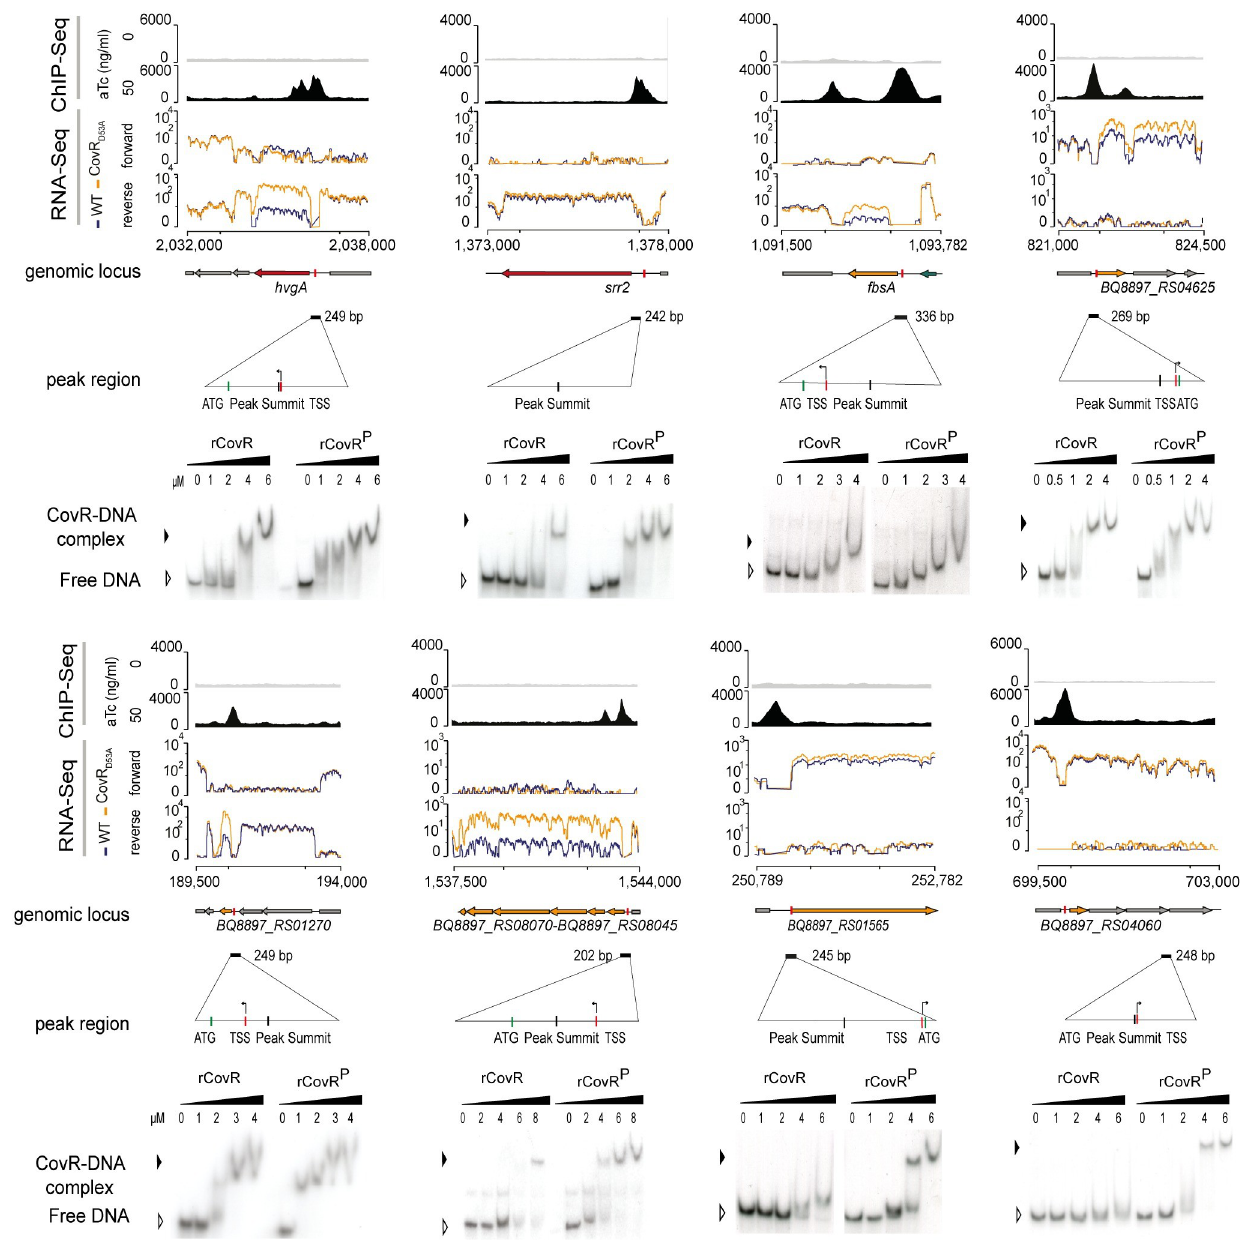
Fig 3. Direct and complex CovR transcriptional regulation. ChIP-seq and RNA-seq profiles showing CovR binding and the associated transcriptional signal for eight selected loci. From each locus is shown from top to bottom: i) the non-induced (anhydro-tetracycline (aTc) = 0: upper gray line) and induced (aTc = 50 ng/ml: bottom dark profile) ChIP-seq profiles with the normalized sequencing coverage scale indicated on the left axis; ii) the normalized strand-specific RNA-seq profiles of the WT (blue) and CovR D53A mutant (yellow) of the same genomic region with the chromosomal coordinates; iii) the schematic representation of ORFs in the locus, with the name of the regulated genes; iv) the position and size (202 to 336 bp) of sequences encompassing the ChIP-seq peaks, with a zoom in to highlight the position of the peak summits, the TSS, and the ATG; and v) the validation of CovR binding by EMSA with the recombinant purified rCovR. The formation of a rCovR-DNA complex is visualized by a delayed migration of the radiolabeled probe compared to the unbound probe (free DNA) and the affinity of rCovR to DNA is increased upon its phosphorylation by acetyl phosphate (denoted as rCovR P ). Note that for three loci ( srr2 , BQ8897_RS01565 , and BQ8897_RS04060 ), CovR binding is not associated to a significant transcriptional change in the CovR D53A